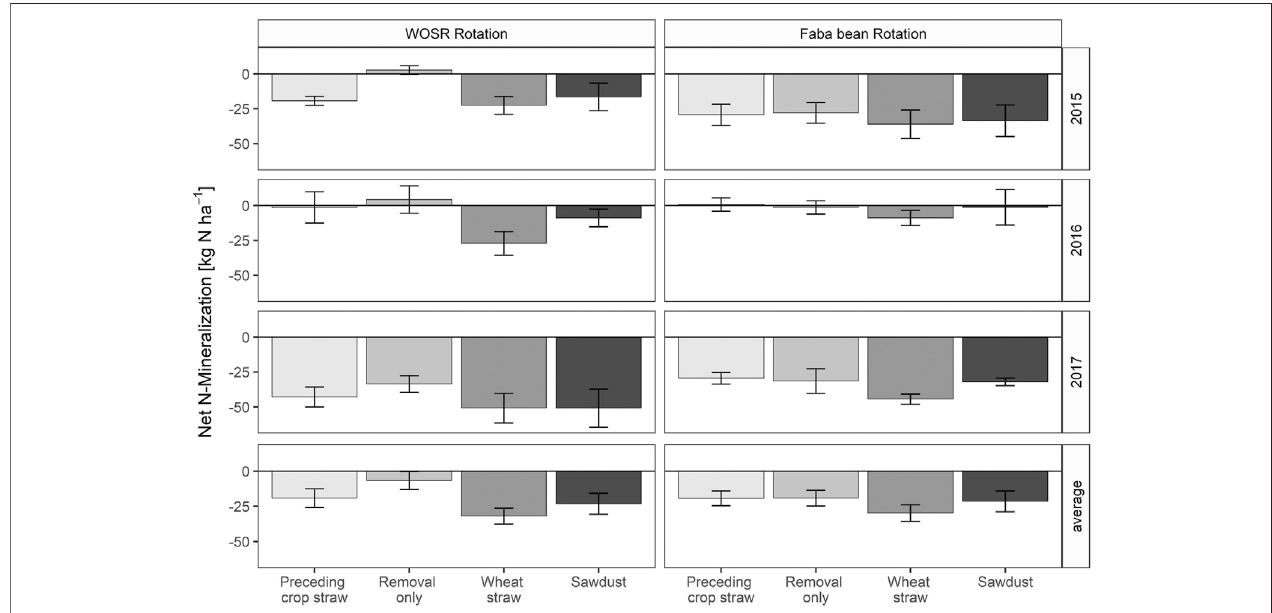
FIGURE 5| Difference ofSMN concentrations in 0 – 90 cm depth at the preceding crop harvest and the beginning of December ( (cid:2) Net N-Mineralization); error bars indicate standard error.